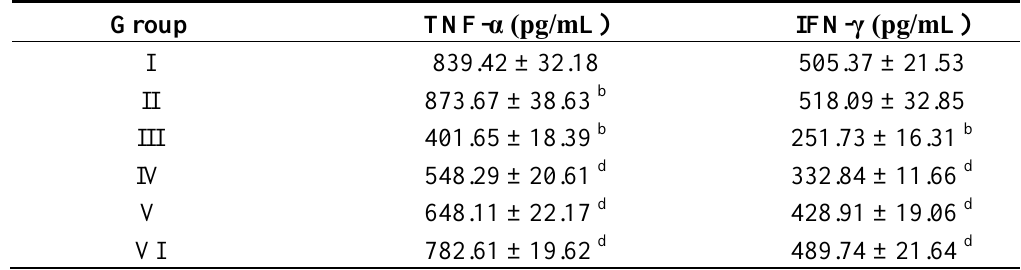
Table 5. Effect of tea polyphenol on serum tumor necrosis factor-alpha (TNF-α) and Interferon-gamma (IFN-γ).